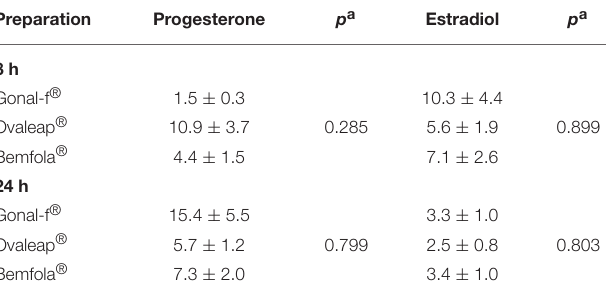
FIGURE 4 | STARD1 and CYPA19A1 gene expression analysis. The expression of STARD1 (A) and CYPA19A1 (B) gene was evaluated in hGLC stimulated for 12h with the EC 50 of Gonal-f ® or biosimilars (12ng/ml Gonal-f ® and Ovaleap ® , 24ng/ml Bemfola ® ) by real-time PCR. Each value was normalized over the RPS7 gene expression (means ± SEM; n = 4). Unstimulated cells served as control and are indicated as a dotted line. (*= significant vs. Bemfola ® , Kruskal Wallis test; p < 0.05). TABLE 6 | FSH EC 50 values (ng/ml) in inducing 8 h- and 24 h-progesterone and estradiol production induced by reference and biosimilar follitropin alfa preparations (means ± SEM; n = 5) in human primary granulosa cells.